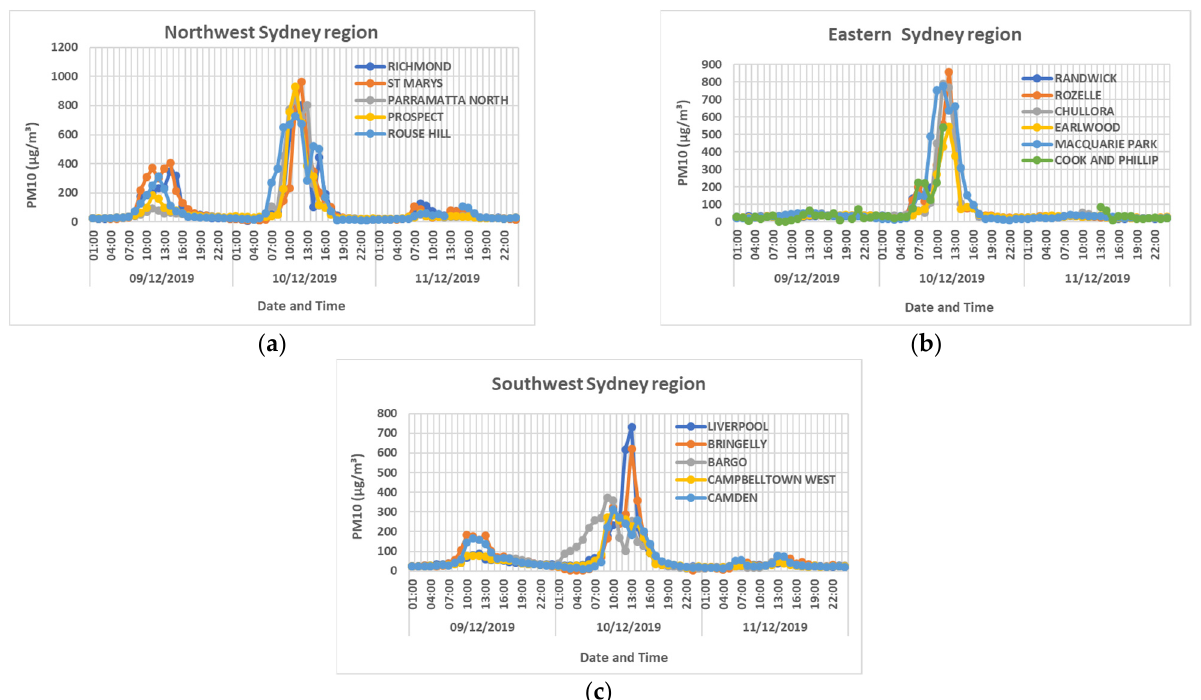
Figure 4. The EST hourly concentration of PM 10 recorded by air quality monitoring stations in ( a ) northwestern, ( b ) eastern, and ( c ) southwestern Sydney region between 9 and 11 December 2019. The station locations are shown on Figure 2.